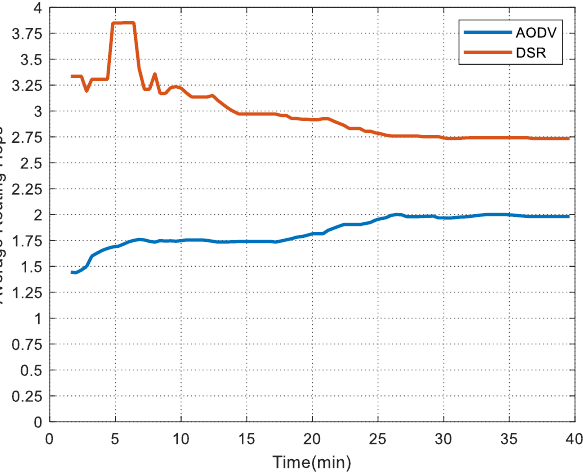
Figure 4. Comparison of average routing hops for AODV and DSR routing protocol.